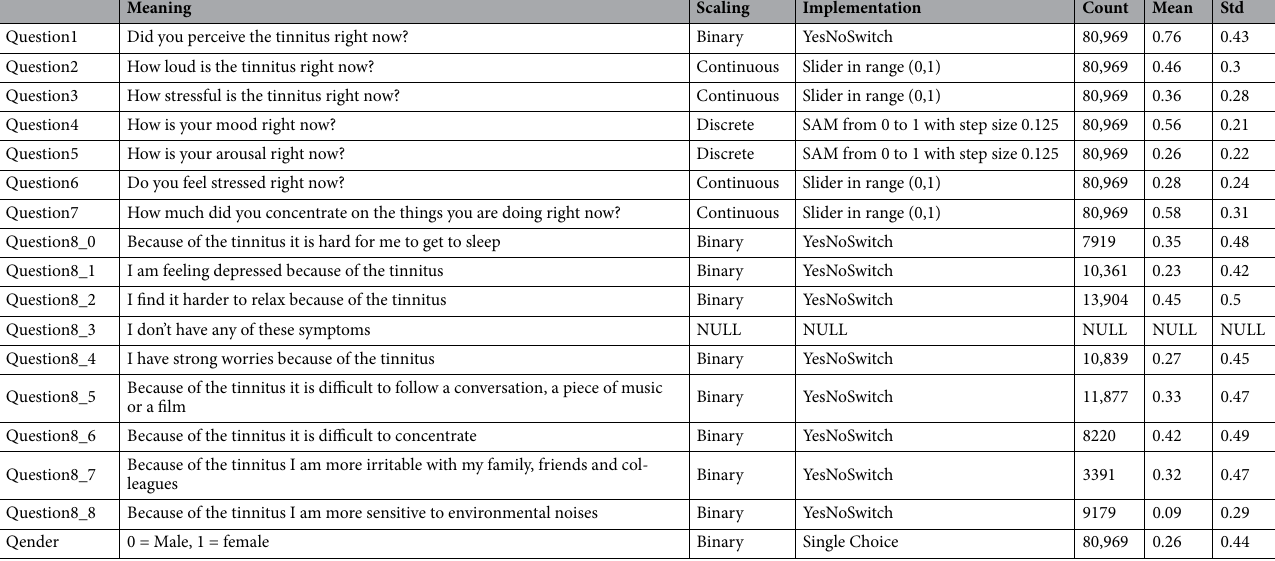
Table 3. Description of the dataframe used for the machine learning approaches. Note that the count for the questions 8_0, 8_1, ..., q_8 is dependent on the number of individuals that selected this answer in the baseline questionnaire. If an individual selected I don’t have any of these symptoms , no follow-up question appeared, so that these values are NULL . SAM = Self Assessment Manikin 65 .